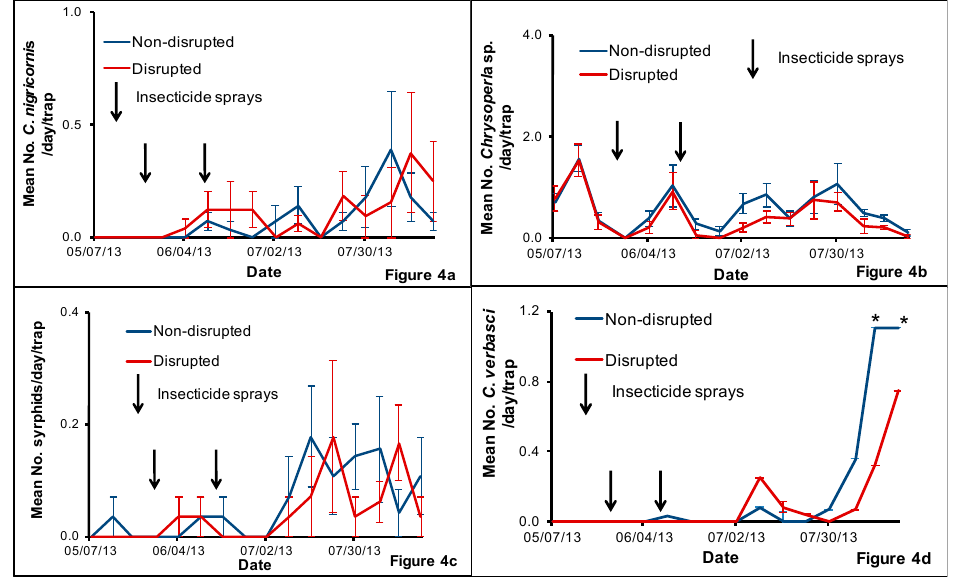
Figure 4. Mean number ( ± SE) of adult Chrysopa nigricornis ( a ), Chrysoperla sp. ( b ), syrphids ( c ) and Campylomma verbasci ( d ) captured per day per trap on HIPV traps placed in the natural enemy non-disrupted and disrupted plots in a pear orchard in White Salmon, Washington, USA, from May to August 2013. Significant differences between the treatments when present are noted on graphs using an asterisk (* = significance at p ≤